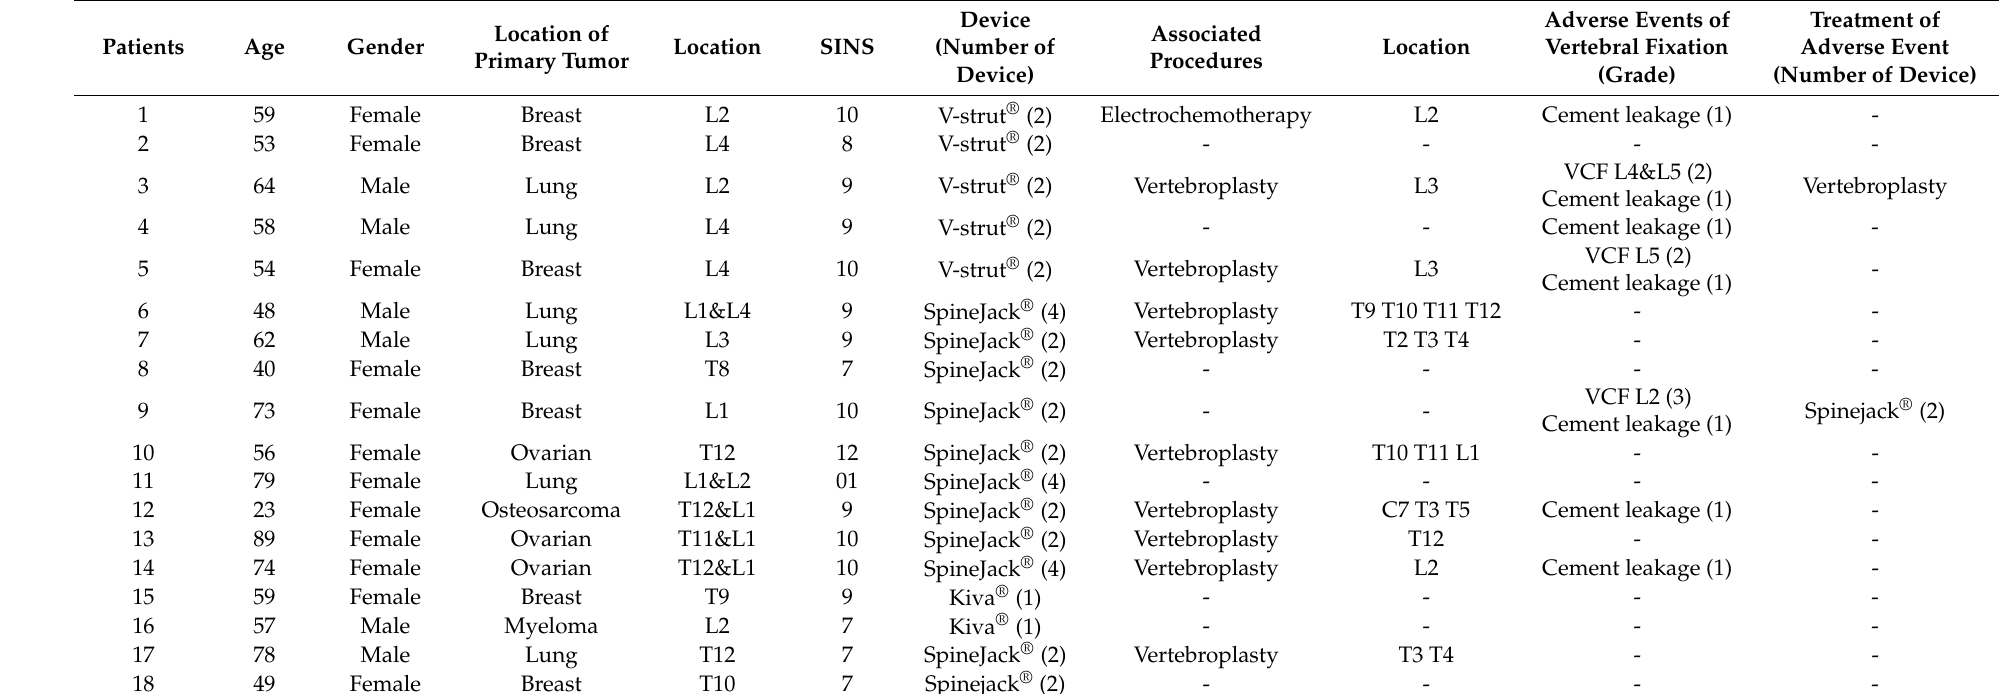
Table 1. Population characteristics and procedure